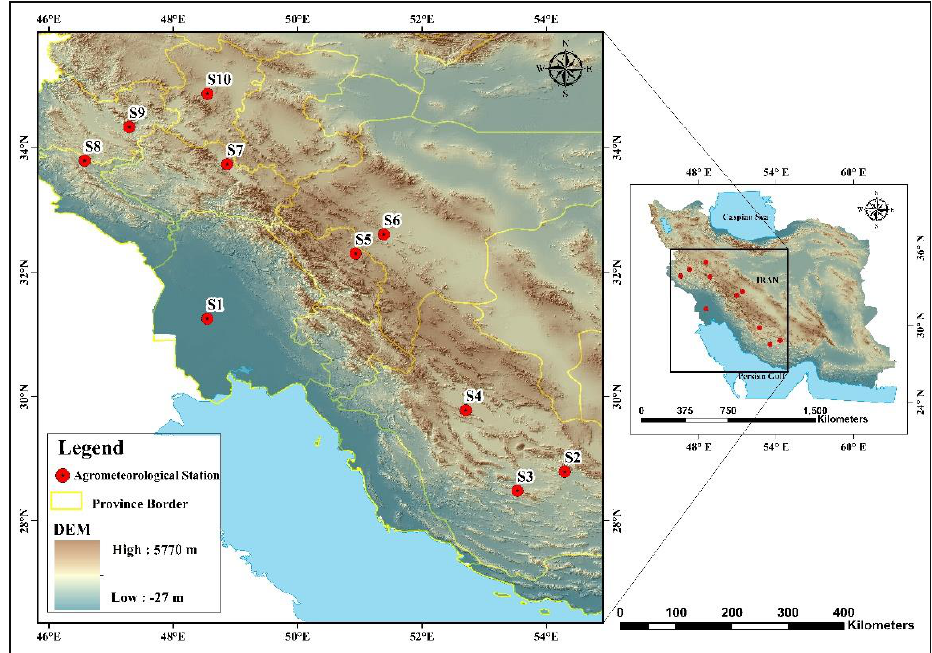
Figure 1. Study area: geographical location of agrometeorological stations.